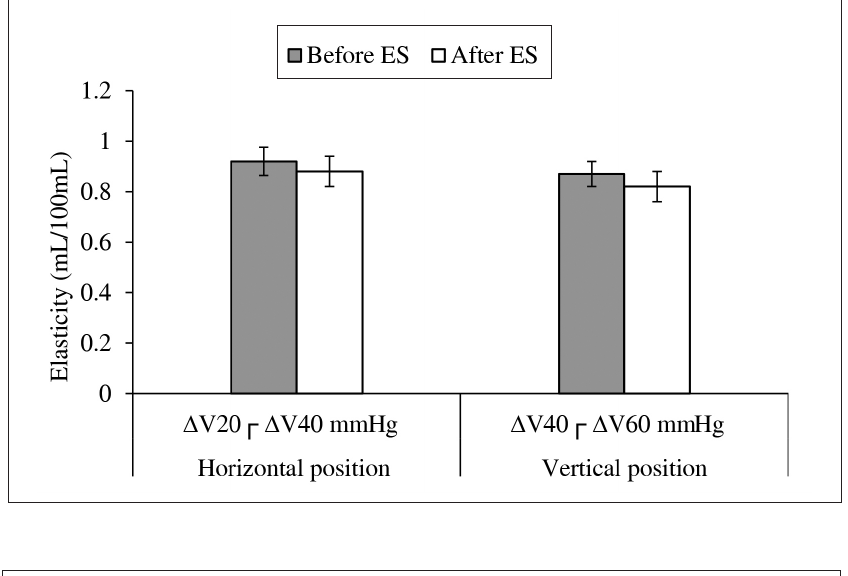
Figure 4. Duration of time to reach balanced arterial and venous blood flow rates in the horizontal position before, during and after the EMS ( x ± Sx )